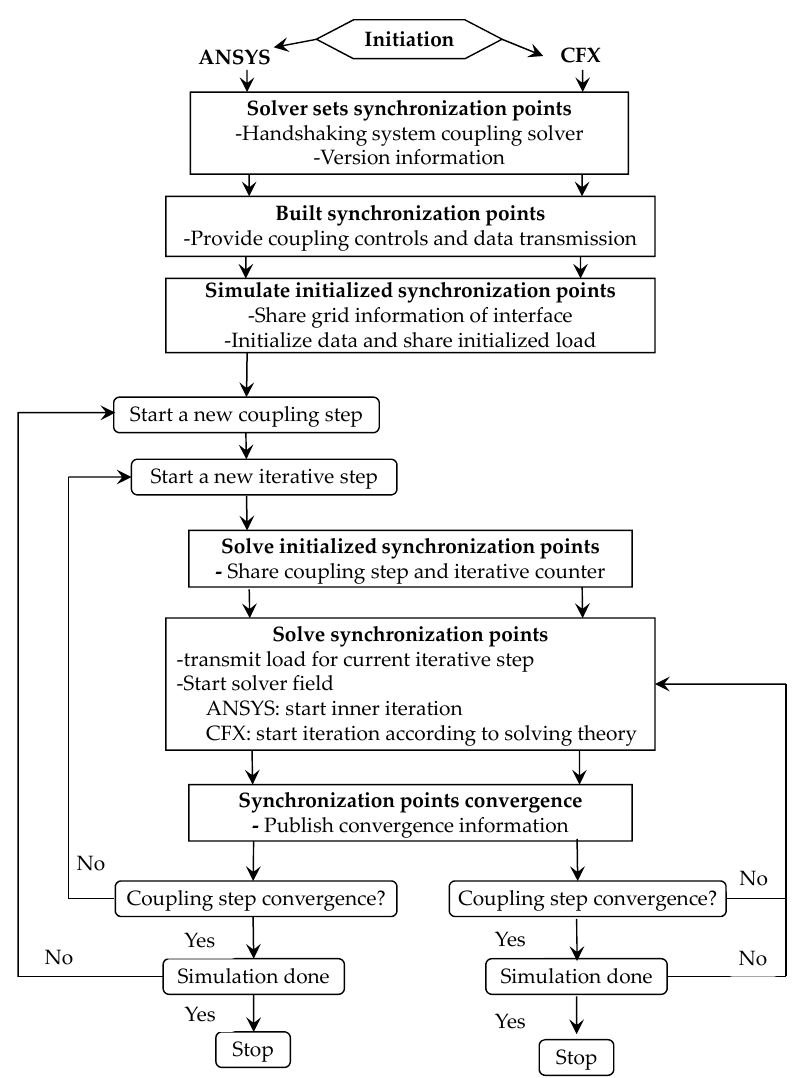
Figure 1. Process of data exchange between fluid solver and structure solver.